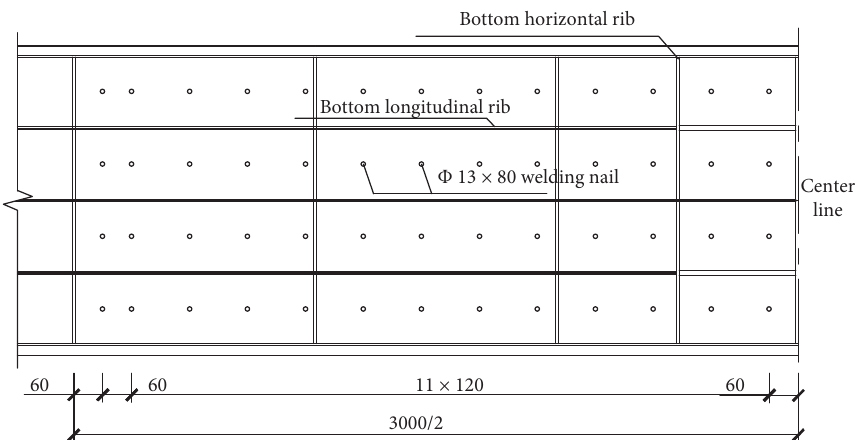
Figure 3: Layout of welding nails on the bottom plate (unit: